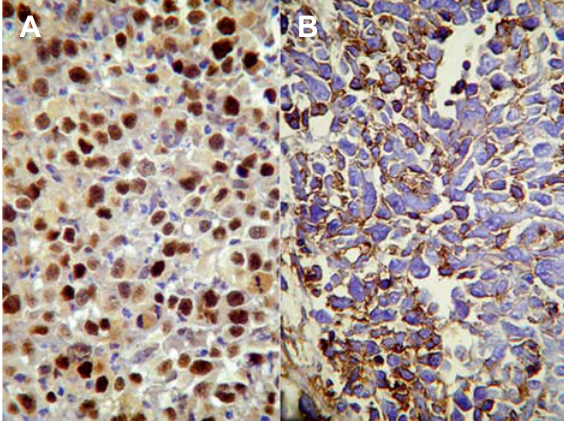
Figure 4 – A) Immunohistochemistry study of strong and diffuse expression of Cyclin D1 in the nuclei of tumor cells. Tumors from mice submitted to curcumin instillation showed a mean reduction of 13% in Cyclin expression in comparison with control